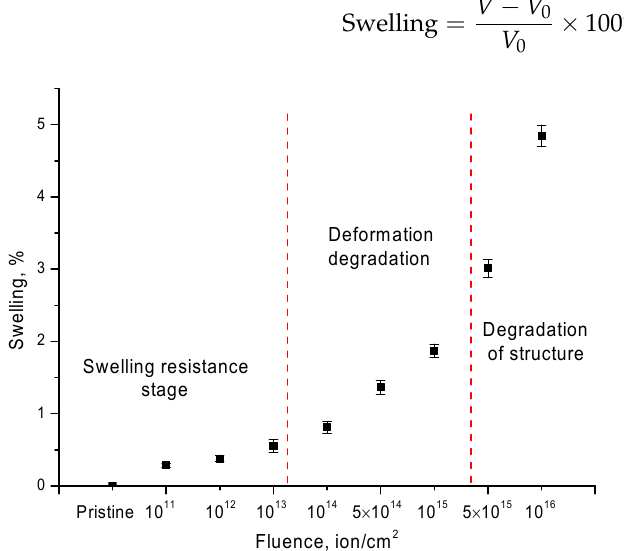
Figure 6. Dynamics of changes in the crystal lattice swelling value. The general view of the dynamics of changes in the crystal lattice swelling value can be divided into three stages that are characteristic of various fluences. The first stage is typical for irradiation fluences of 10 11 –10 13 ion/cm 2 and is characterized by small